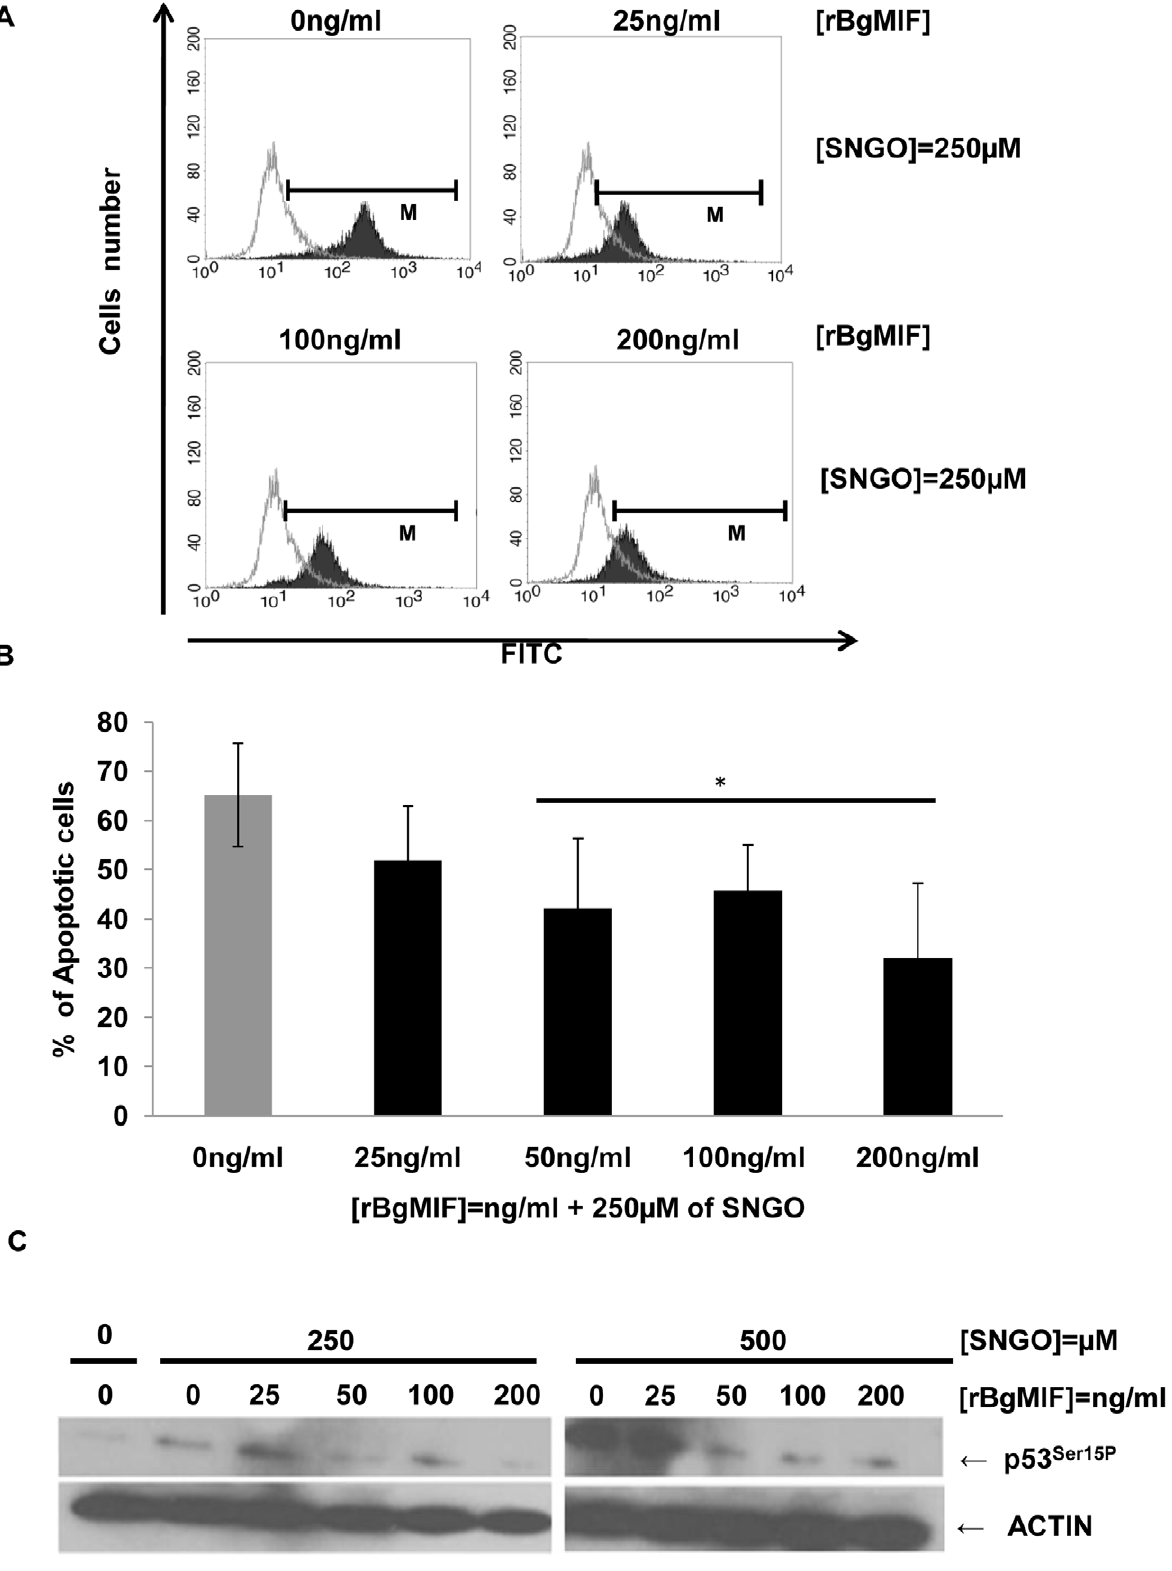
Figure 5. rBgMIF suppresses NO induced apoptosis in Bge cells. (A) Cells treated or not with the NO-donor SNGO were fixed and submitted to a TUNEL assay. The positively stained cells were quantified by FACS. (B) The FACS data are displayed as the percentage of cells undergoing apoptosis, i.e. cells within the limits of fluorescence shown in (A). Results are the mean 6 SD of 3 separate experiments (* p , 0.05). (C) Immunoblotting of cell lysates using an anti-p53 ser15P antibody (p53P 15 ) and an anti-actin antibody to control for protein content in each sample.